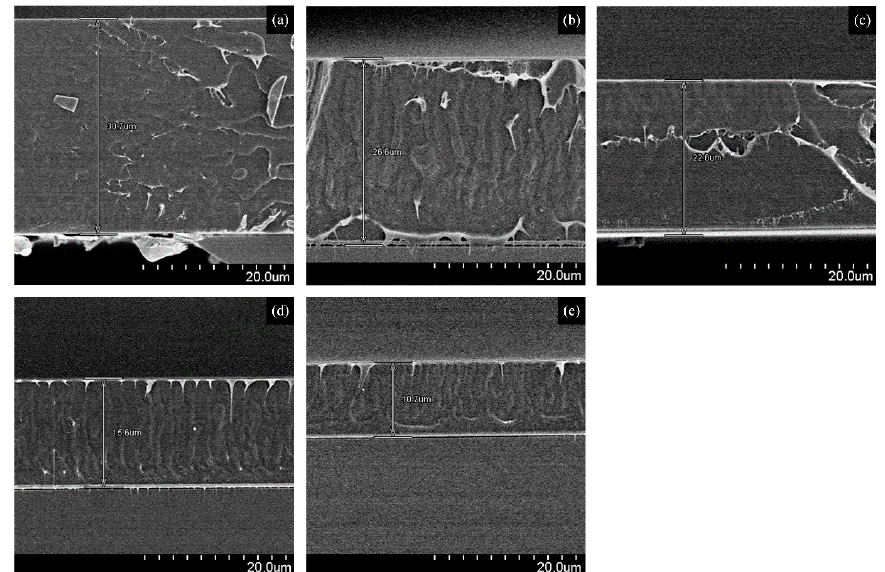
Figure 8. SEM images of different IDC dielectric/sensing membrane thicknesses: ( a ) 30.7 µm; ( b ) 26.6 µm; ( c ) 22.0 µm; ( d ) 15.6 µm; and ( e ) 10.7 µm.